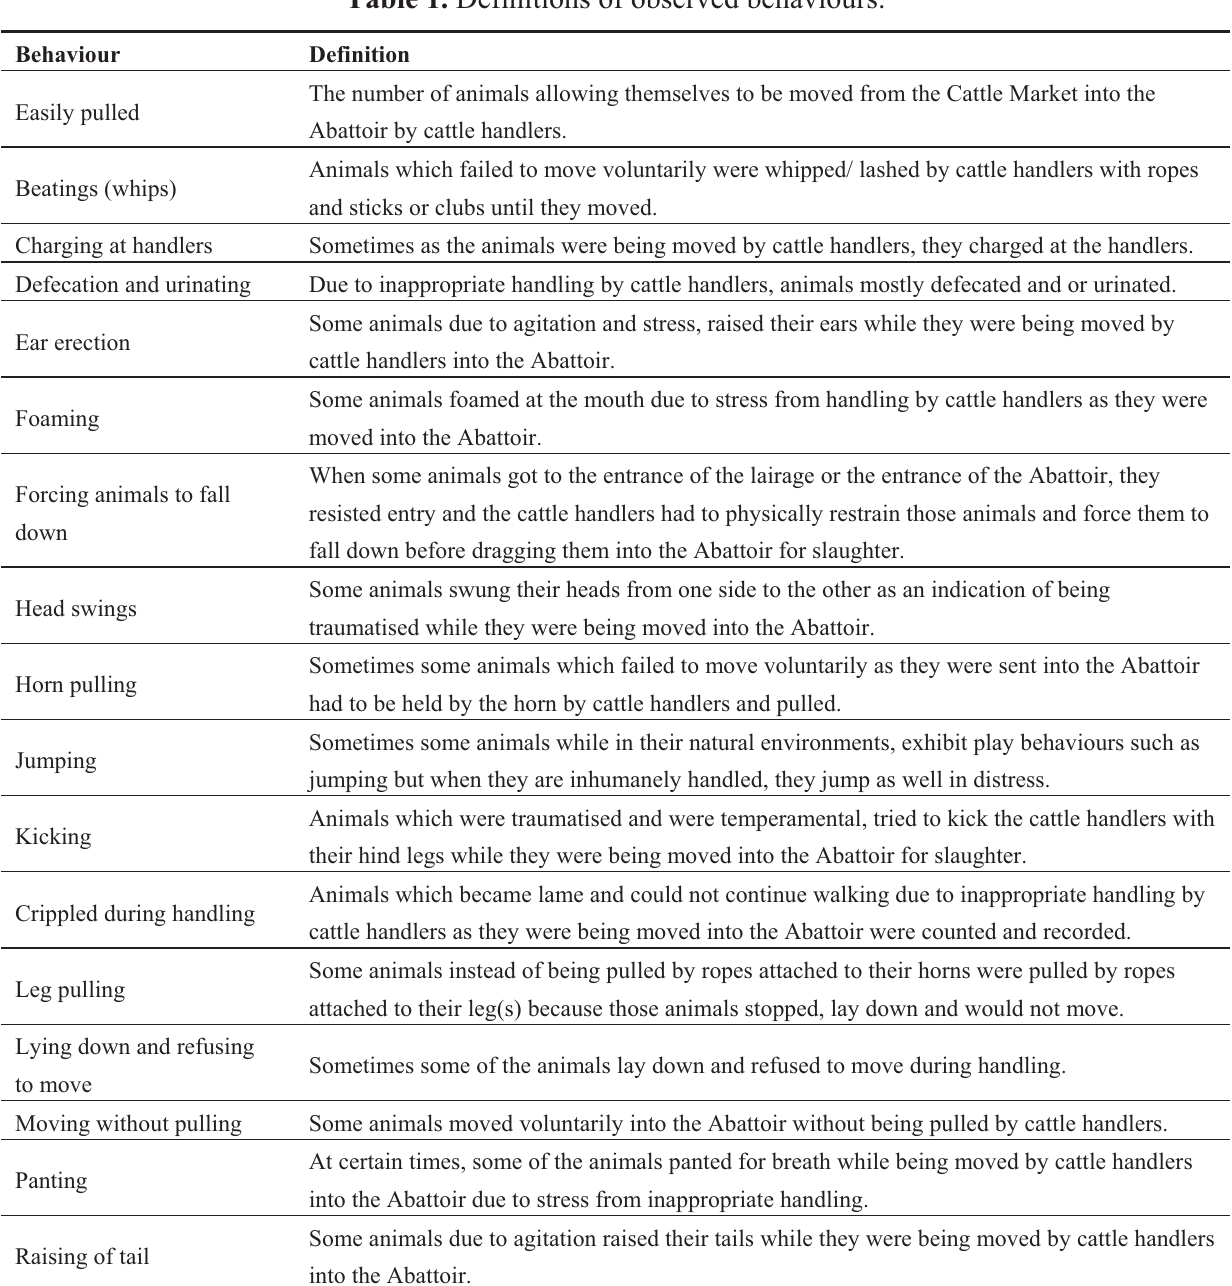
Table 1. Definitions of observed